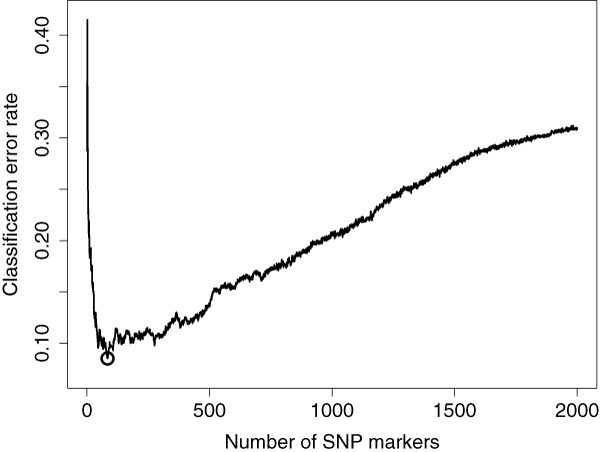
Classification error rates of random forests using up to the first 2,000 most important SNPs. x-axis is the number of SNP markers used. y-axis is the classification error rate given by the random forest (one million trees). The circle (with 84 markers and an error rate of 8.5%) represents the minimum in this curve.